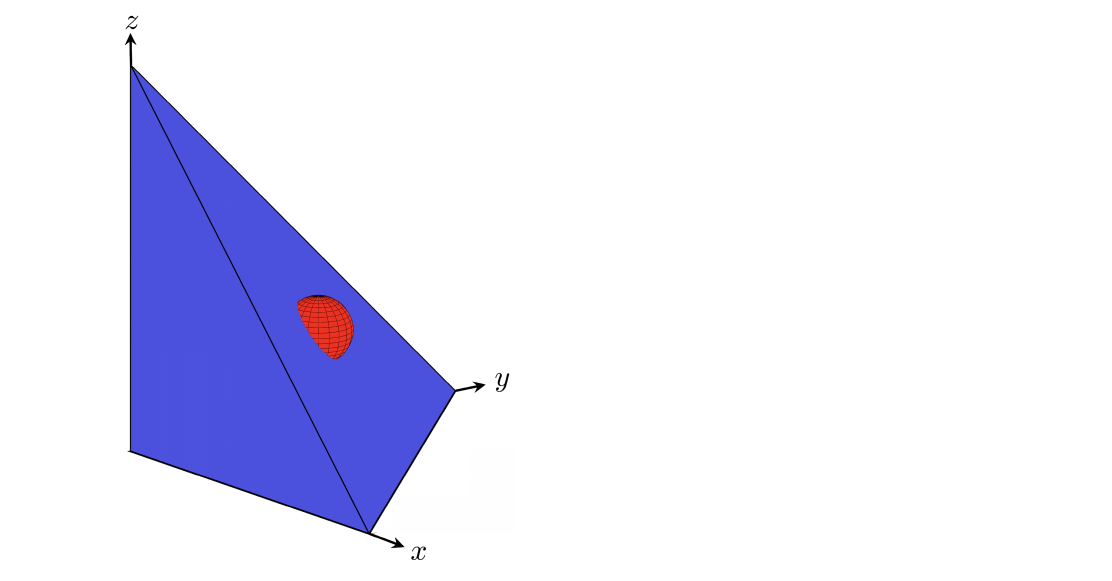
Figure 8. The coordinated demand subspace for a 3-player GDD game with subsidies. The hemi- sphere protruding from the 2-simplex face shows the